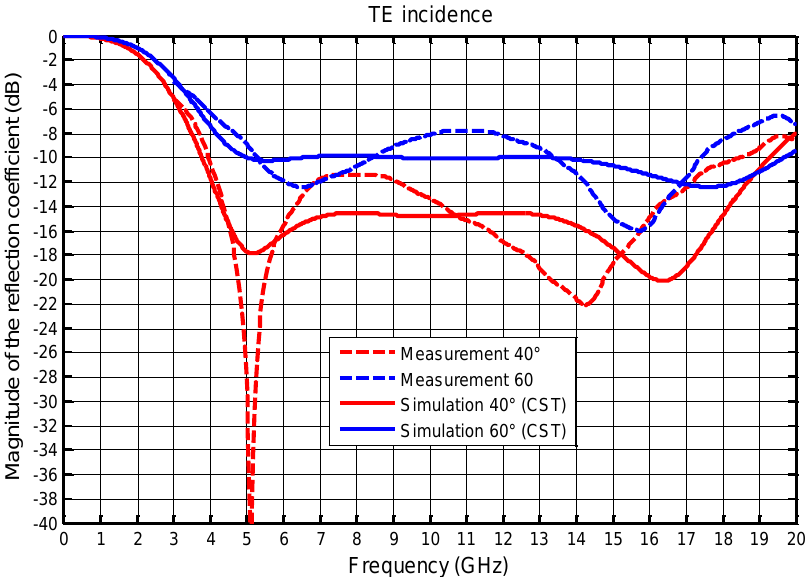
Figure 6. Comparison between the simulated and measured magnitudes of the reflection coefficient (dB) as a function of frequency with two angles of incidence 40° and 60° for TE polarization.